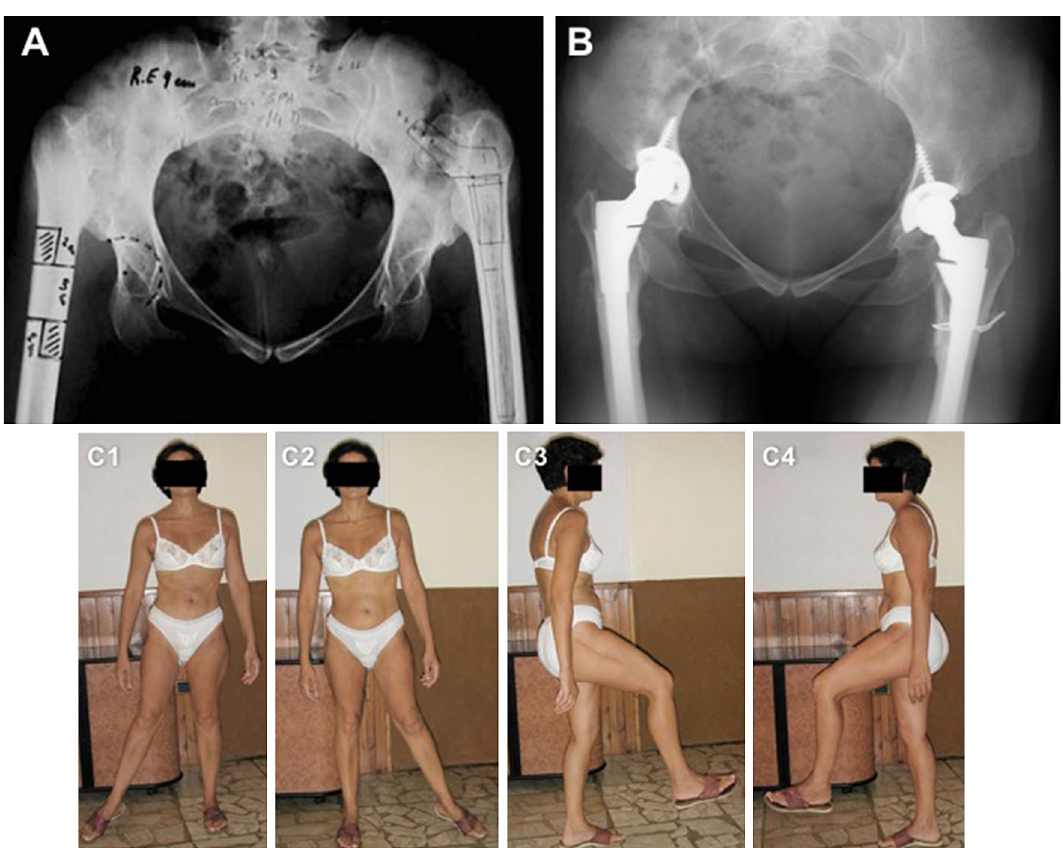
Fig. 1 44-year-old female patient with bilateral DDH. a Pre-opera- tive planning with the Z-shaped osteotomy. b X-ray at 2-year follow- up right hip surgery (1-year; left hip). Note the intra-op fracture on the